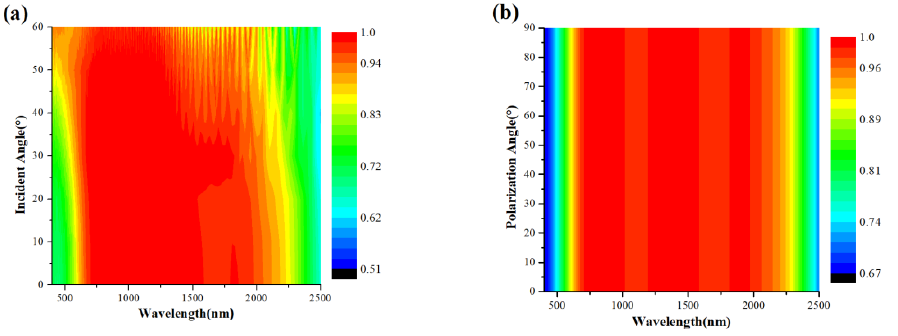
Figure 11. Absorption of MXene/tungsten-based absorber at ( a ) different incidence angles and ( b ) different polarization angles.